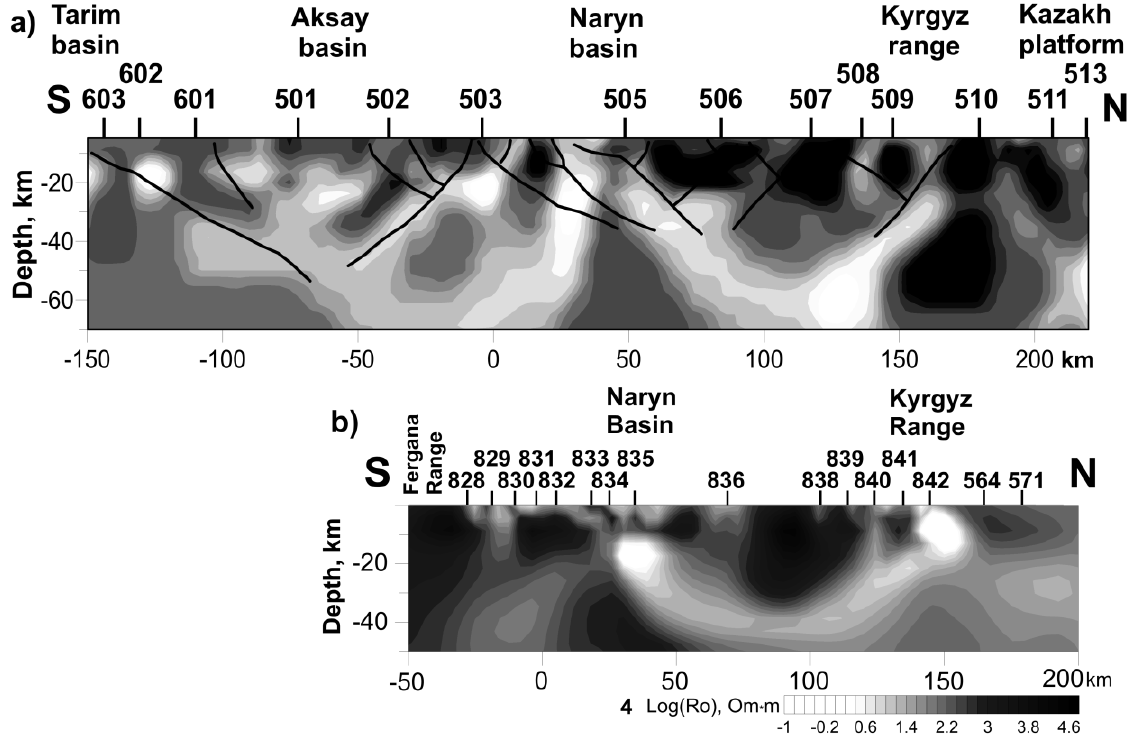
Figure 9. ( a ) Geoelectric section along the MTS Naryn profile [80]; ( b ) geoelectric section along the MTS Kekemeren profile [82]. Lines at Naryn profile indicate faults.